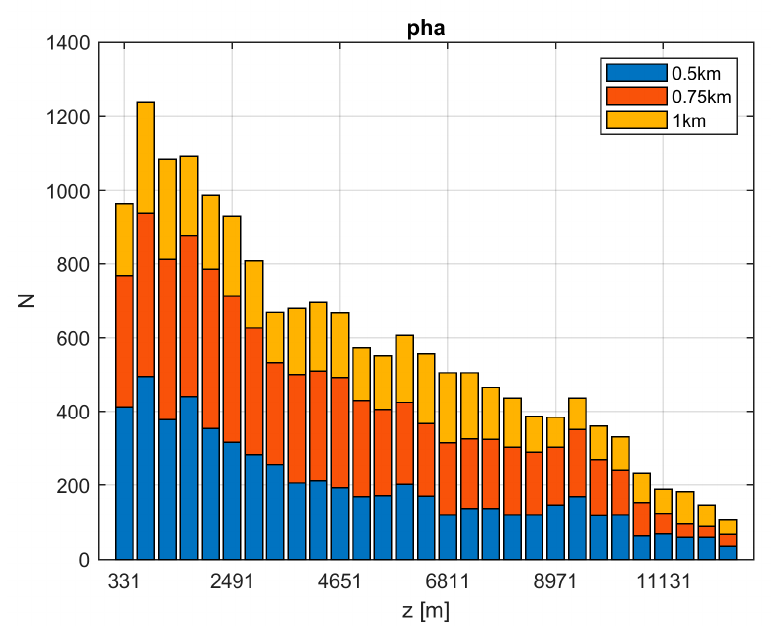
Figure 8. Measured data counts (N, y-axis) for pha in individual vertical layers containing each ngate = 15. The x-axis displays the height of layer centers (z [m]) and blue columns show the number of data in “near(0.5 km).” The number of data in “near(0.75 km)” is the sum of blue and red columns, whereas the number of data in “near(1 km)” is the sum of blue, red and yellow columns. Remote Sens. 2020 , 12 , x FOR PEER REVIEW